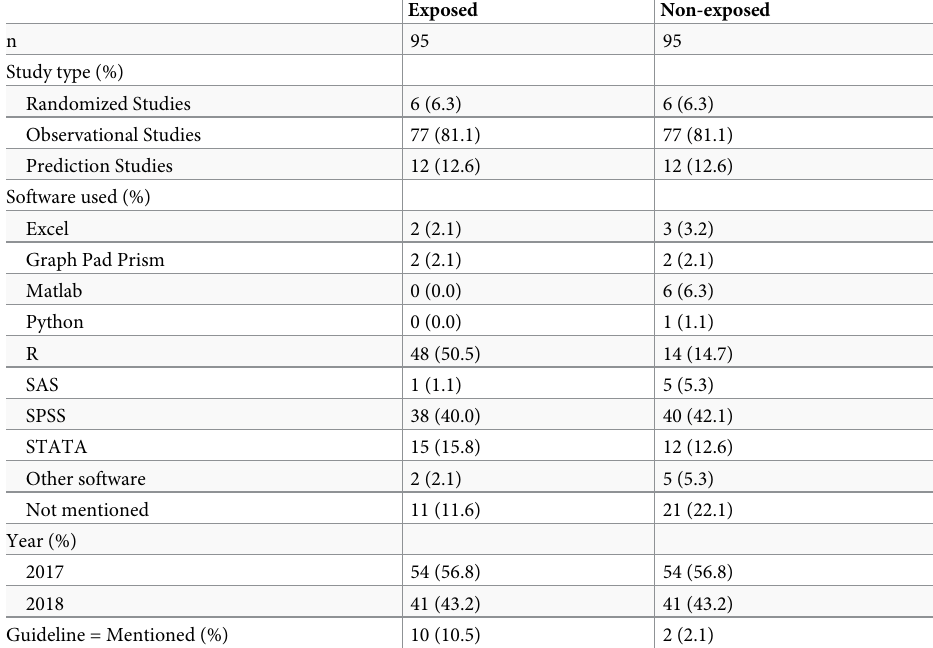
Table 1. Descriptive